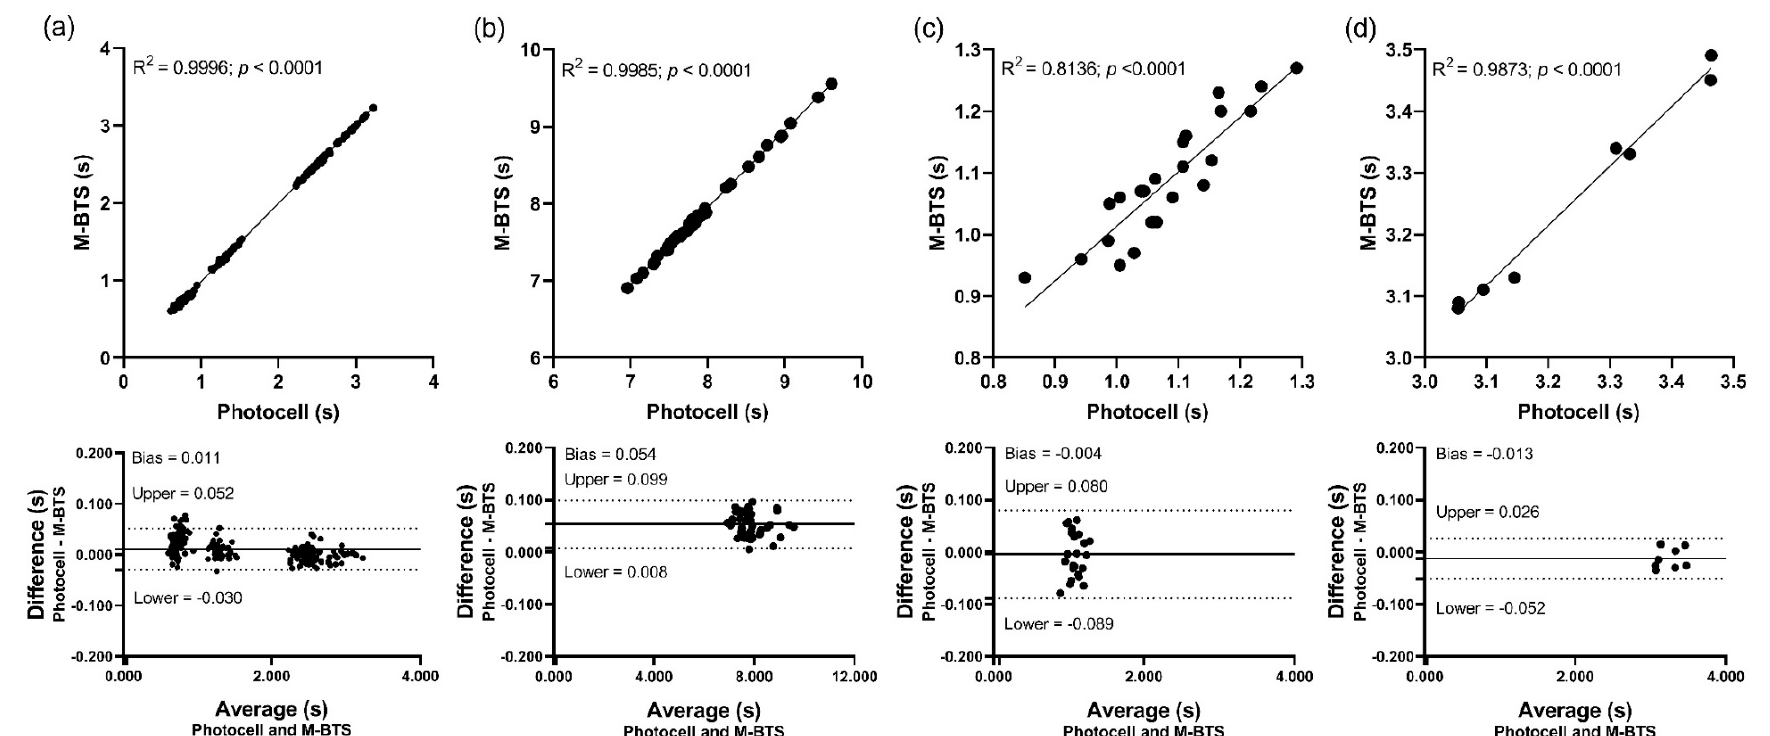
Figure 3. Scatterplots (above) and Bland-Altman plots (below) of time measured by M-BTS against the actual time obtained from Photocells. The diagonal line represents the identity line (slope = 1; intercept = 0). The solid line within the graph represents the bias. The broken lines represent the upper and lower 95% limits of agreement. ( a ) Belong to the linear running test and represent the analysis of the different section times, ( b ) belong to the linear running test and represent the analysis of the total time, ( c ) belong to de ski slalom and represent the analysis of the different section times ( d ) belong to de ski slalom and represent the analysis of the total time. M-BTS, magnet-based timing system.